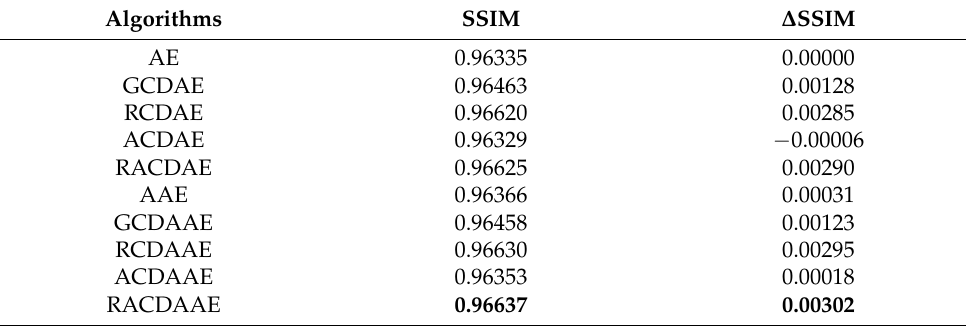
Table 7. Experimental results on the FMNIST data set.